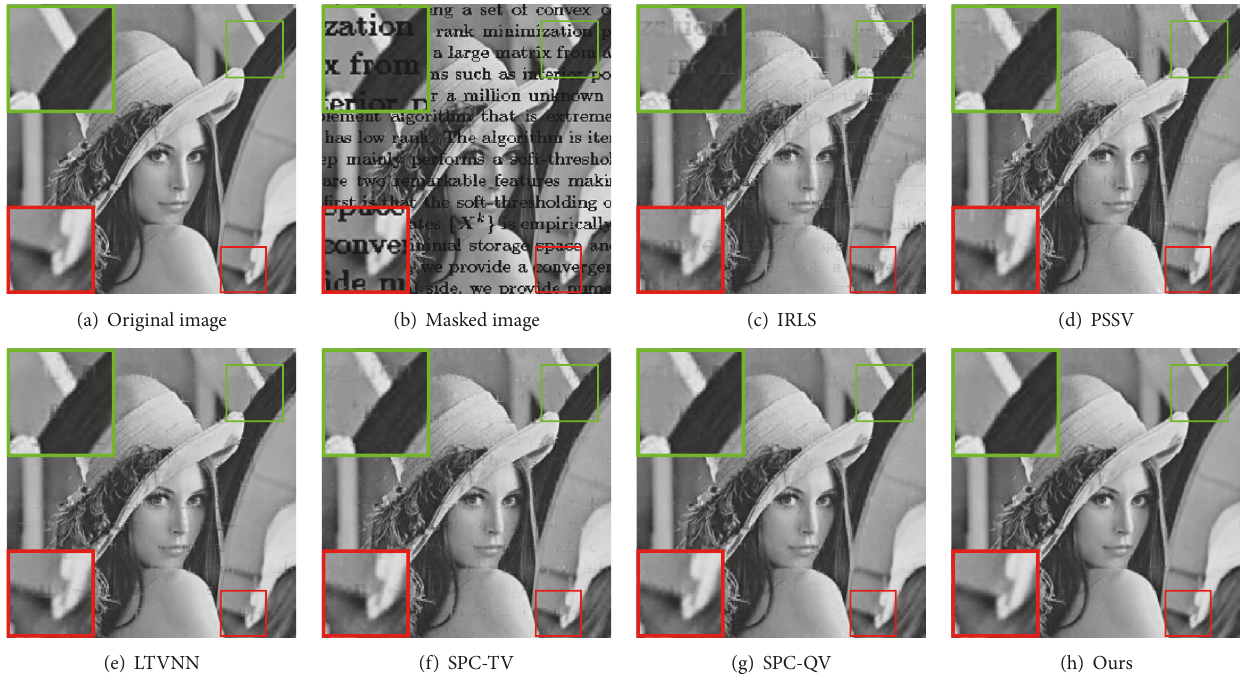
Figure7:VisualresultsonLennaimagewithtextbydifferentalgorithms.(a)Originalimage.(b)Textmaskedimage.(c)IRLS:PSNR=22.14dB, SSIM=0.903. (d) PSSV: PSNR=24.41dB, SSIM=0.929. (e)LTVNN:PSNR=25.33dB, SSIM=0.962. (f)SPC-TV:PSNR=25.33dB, SSIM=0.941. (g) SPC-QV: PSNR=27.07dB, SSIM=0.966. (h) Ours: PSNR=29.12dB, SSIM=0.984. The figure is better viewed in zoomed